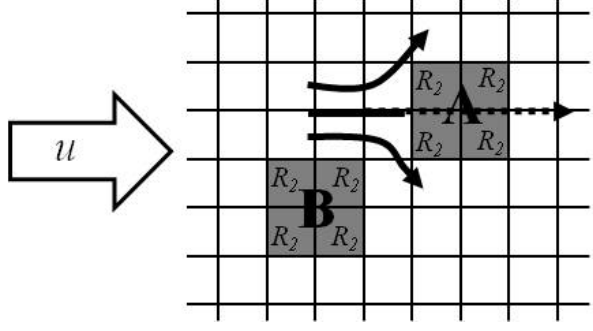
Fig. 8. Description of the ERM application if the building size is larger than the grid size. Table 1. Values of the Manning roughness coefficient (Kotani et al.,